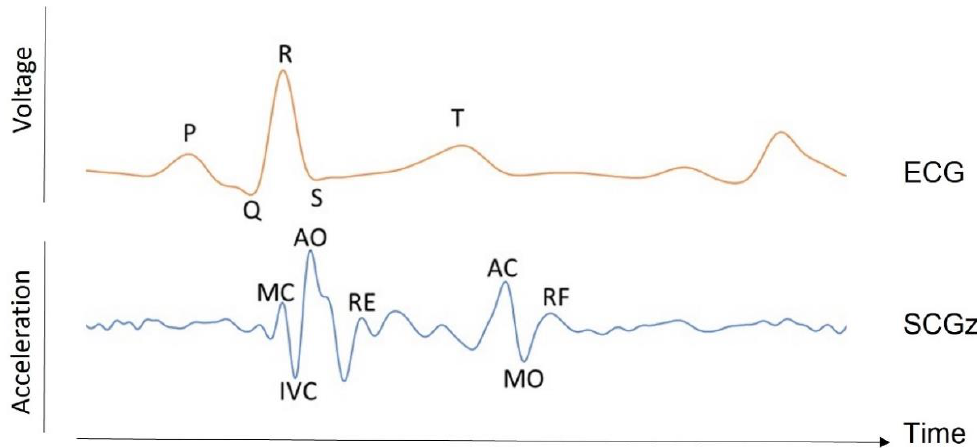
Figure 2. SCG waveform. The time traces of the SCG acceleration signal in the dorsoventral axis (z) for a healthy subject are shown alongside the ECG signal in one heart beat (arbitrary unit). The SCG labels correspond to the mitral valve closure (MC) and opening (MO), aortic valve closure (AC) and opening (AO), rapid ejection (RE), rapid filling (RF), and isovolumetric contraction (IVC).